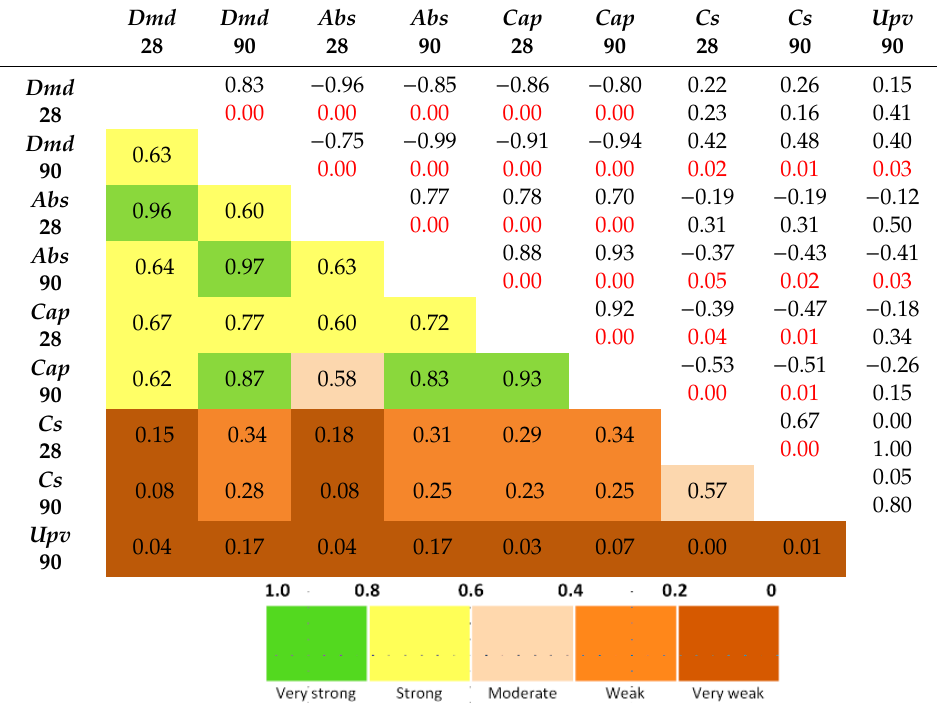
Table 7. Statistical summary of all the variables analyzed.